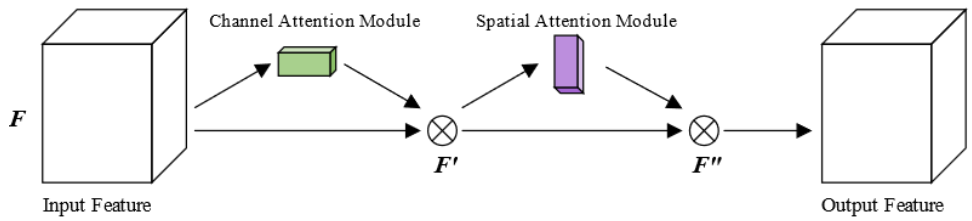
Figure 5. Structure of CBAM attention